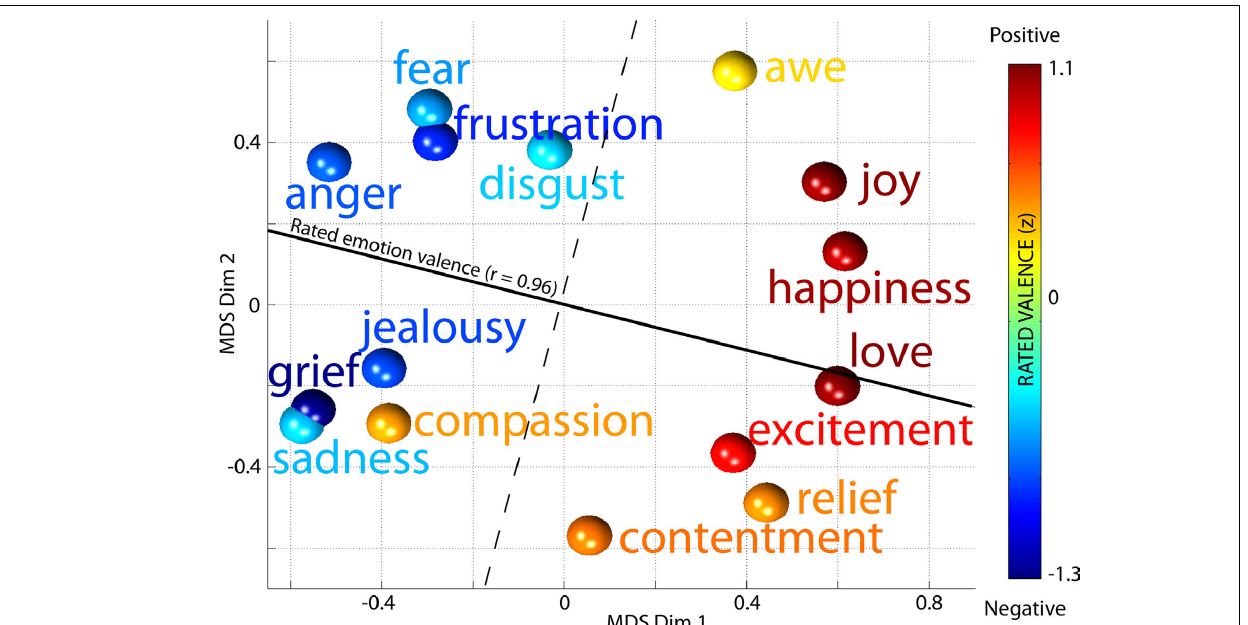
FIGURE 8 | Multi-dimensional scaling of median time weights of broadband IMs for each emotion. Similarities between median IM weights in the 15 emotion periods, drawn from log-spectral decompositions for each subject of brain source ICs only, as represented in the best-fi tting two- dimensional space by non-metric multi-dimensional scaling (MDS). Colors of the balls represent the mean behavioral ratings of (positive or negative) valence of